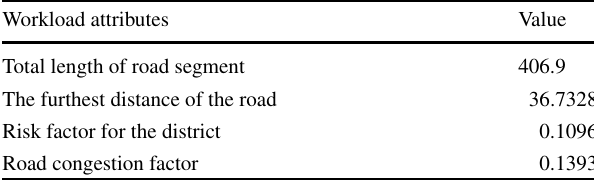
Table 7 Workload attributes of the public dataset in the public dataset